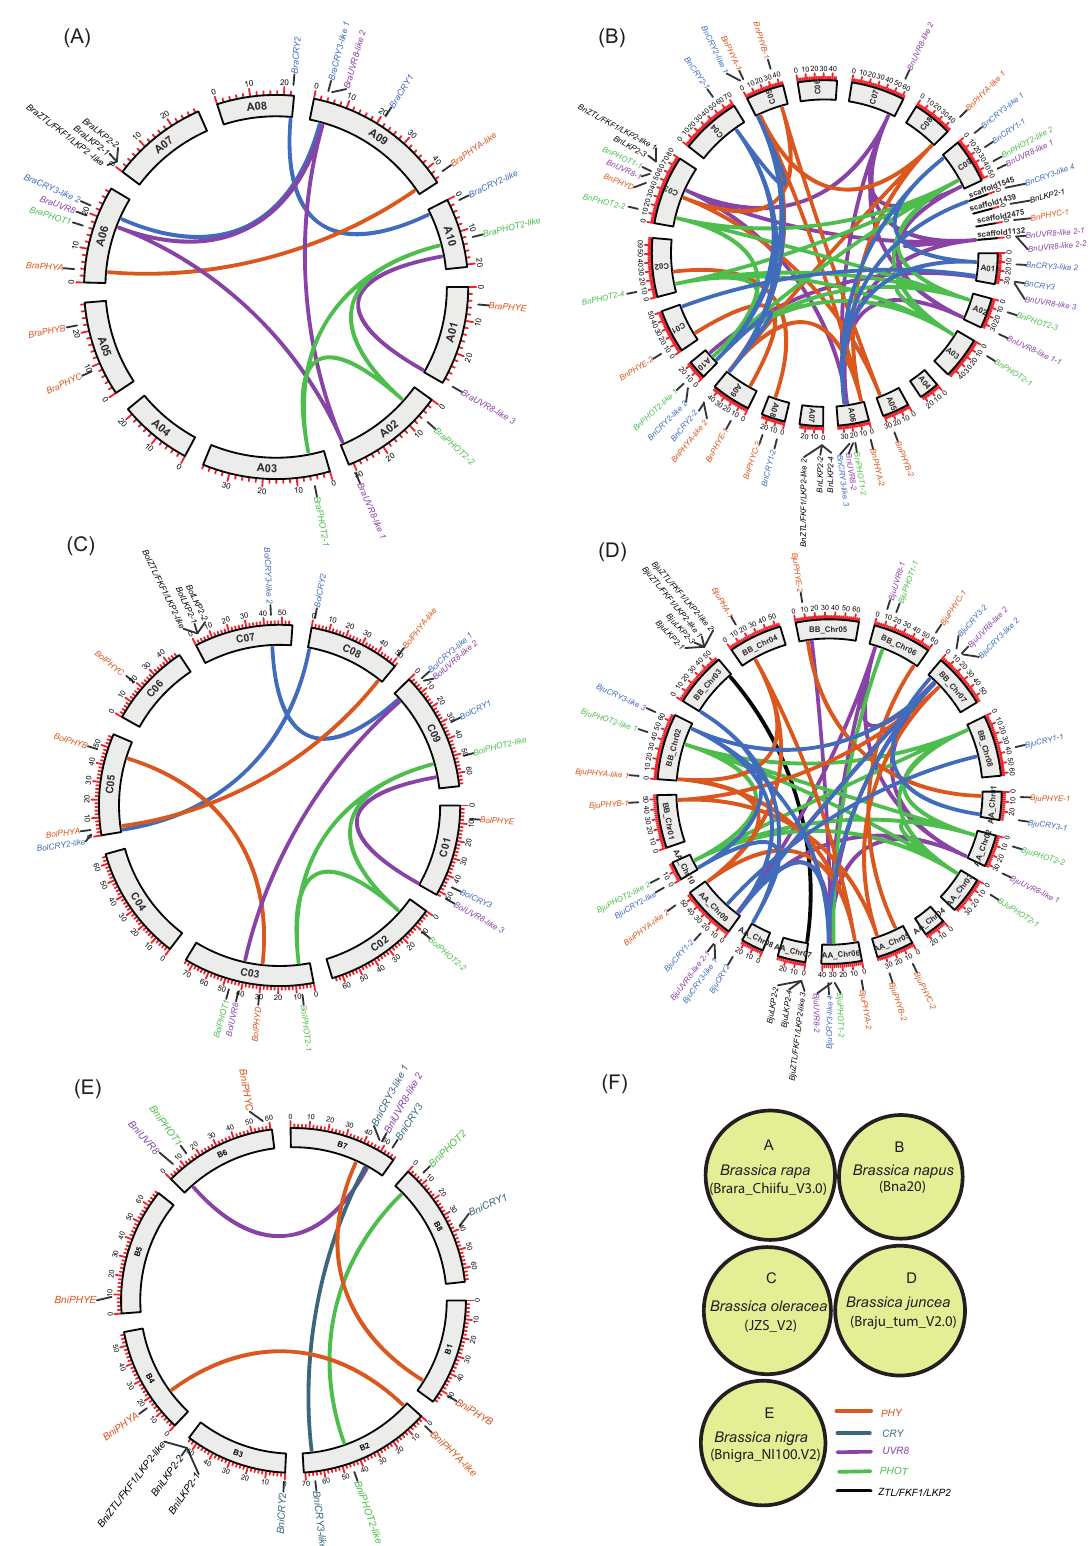
Figure 6. The chromosomal distribution and duplication of photoreceptor genes in Brassica species. ( A – E ) The Circos represent the chromosome maps (in Mbs) of B. rapa ( A ), B. napus ( B ), B. oleracea ( C ), B. juncea ( D ), and B. nigra ( E ). ( F ) describes the reference genomes of Brassica species ( A – E ) utilized for syntenic analyses while the different color schemes indicate the photoreceptor gene